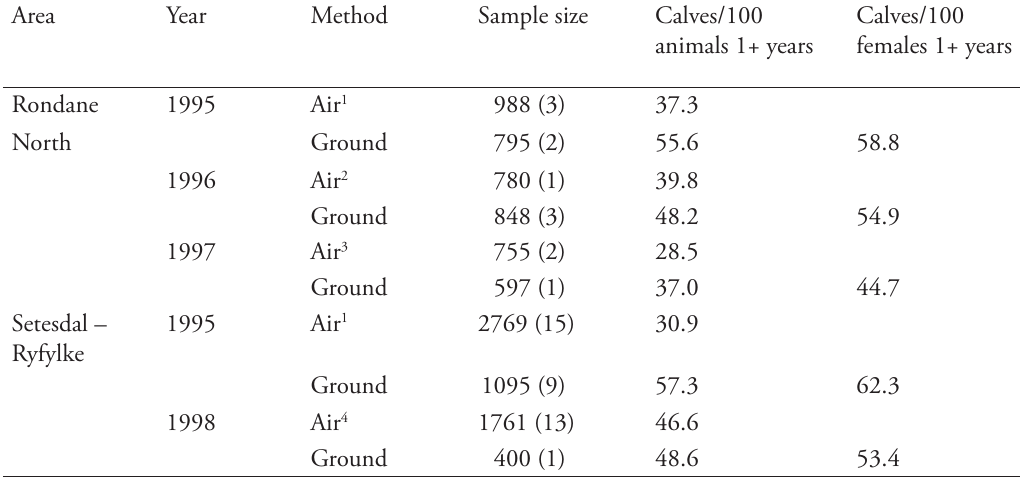
Table 3. Composition in wild reindeer groups ≥ 50 animals in reindeer herds in southern Norway estimated from ground counts and aerial photographs in June-July. Number of groups is in parenthesis. Groups within area and year are pooled and figures are based on accumulated